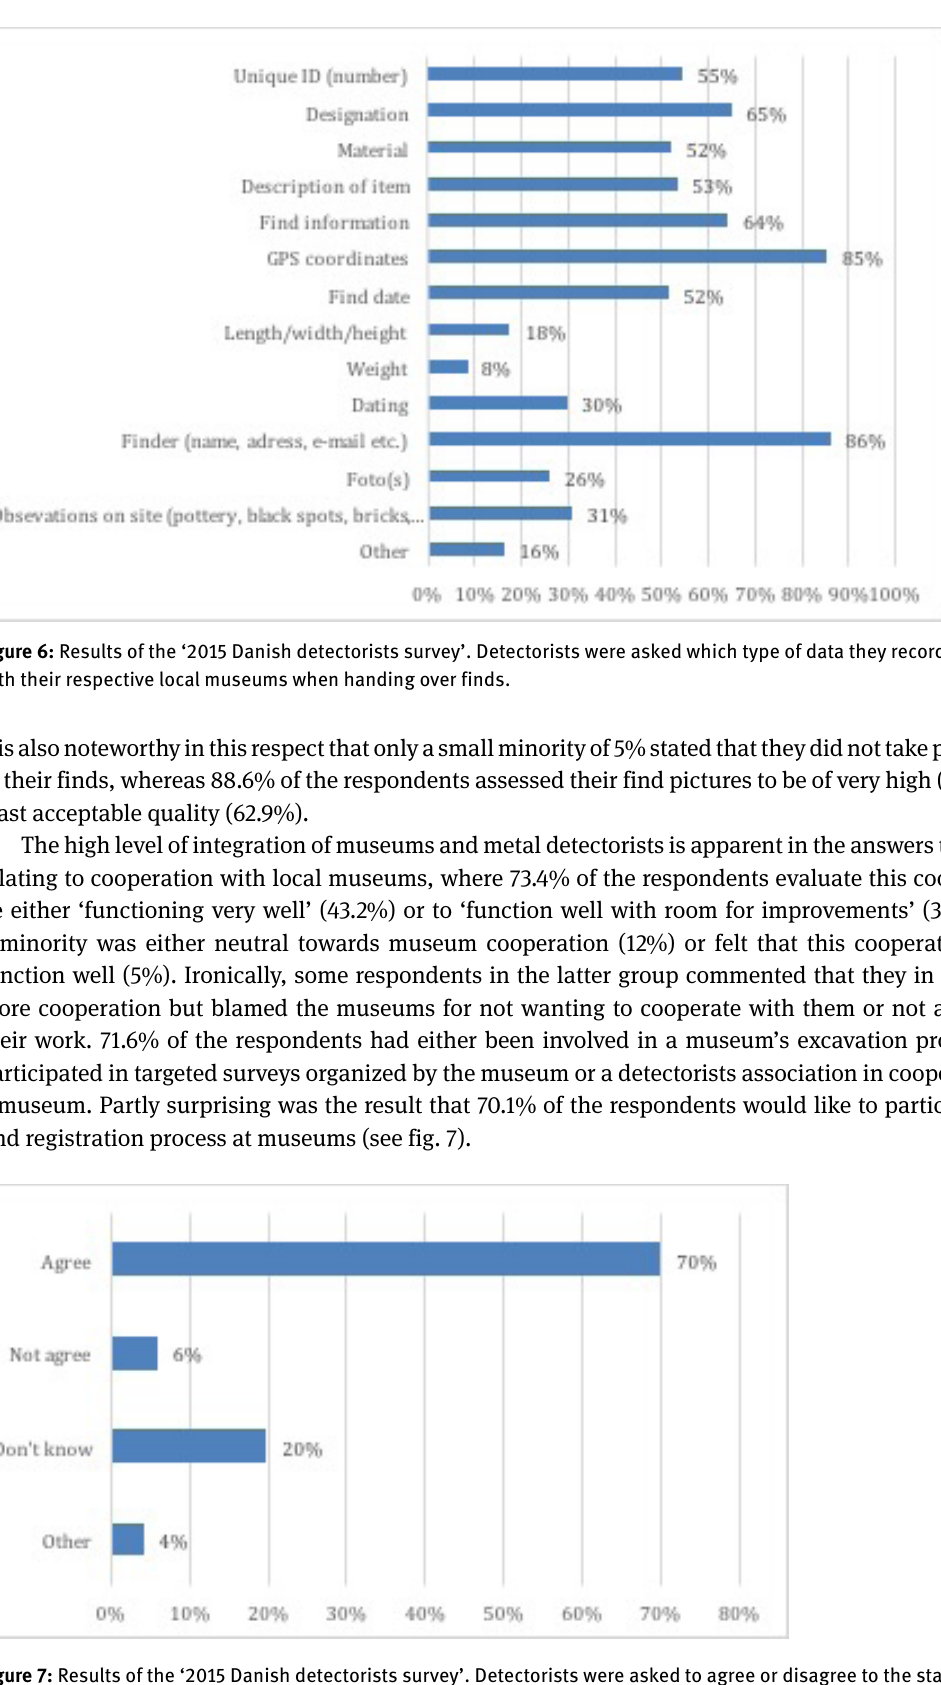
Figure 7: Results of the ‘2015 Danish detectorists survey’. Detectorists were asked to agree or disagree to the statement that it is important that detectorists can participate in the registration of their